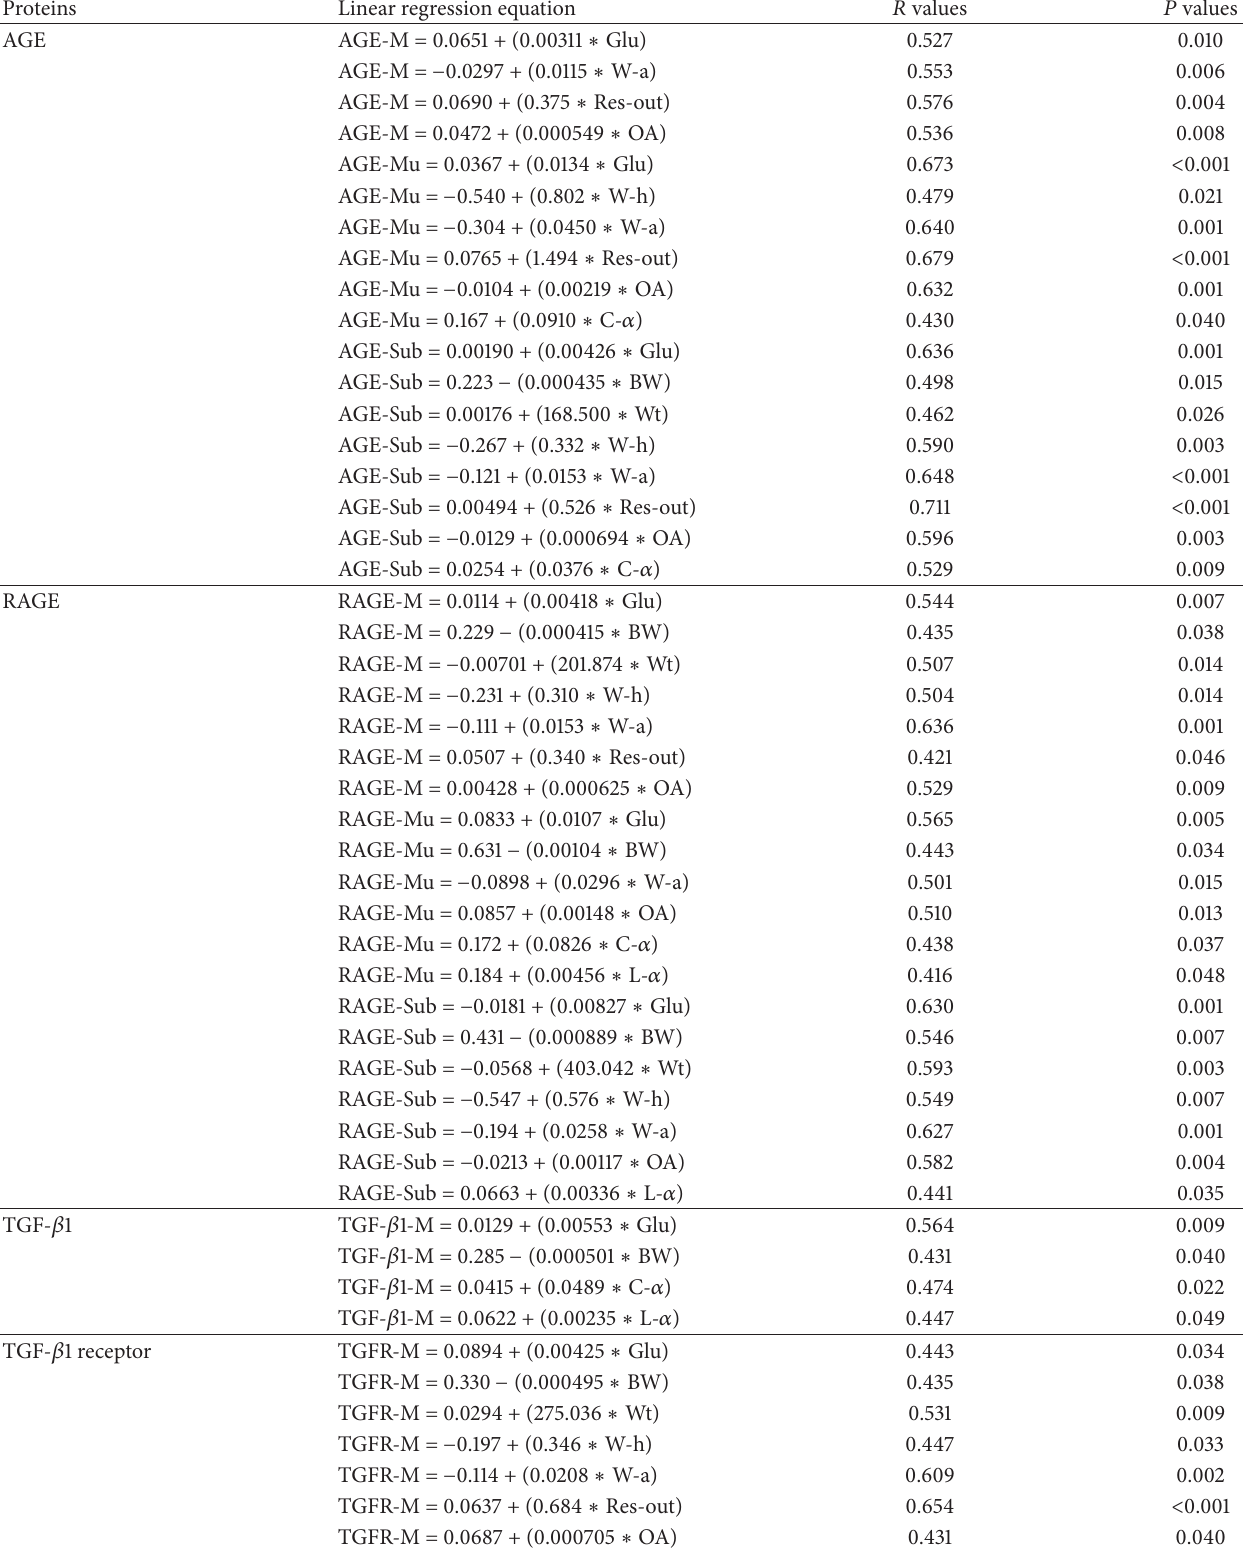
Table 4: The relation between expressions of AGE, RAGE TGF- 𝛽 1, and TGF- 𝛽 1 receptor with other parameters. Proteins Linear regression